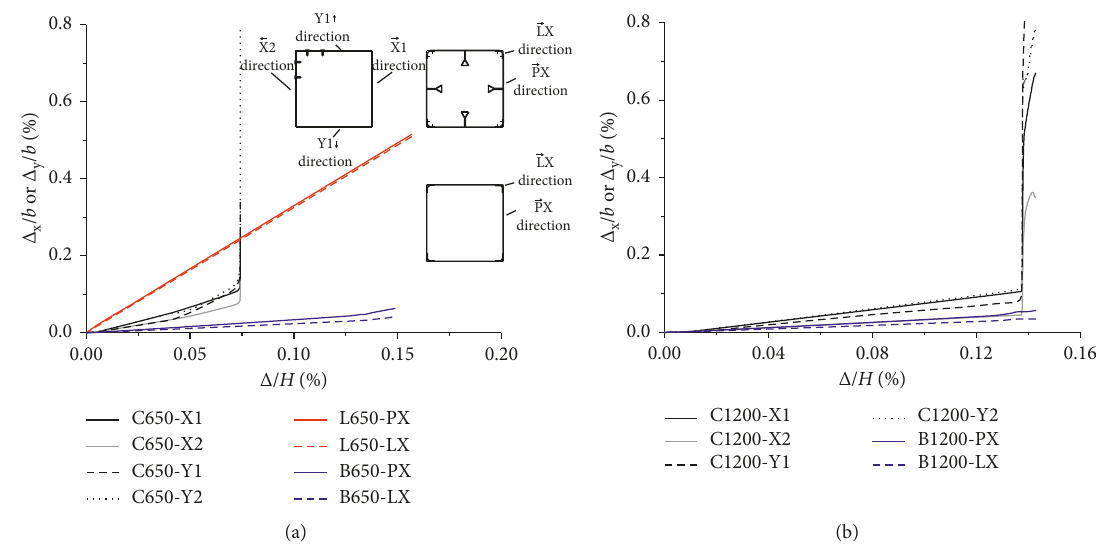
Figure 23: Out-of-plane relative deformation curves, where H is the column length: (a) 650mm column models; (b) 1200mm column models.